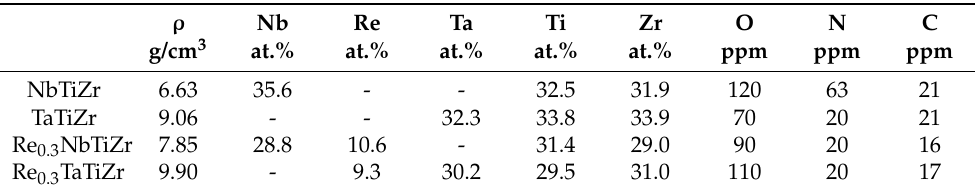
Table 1. Density ( ρ ) and composition of the produced alloys. The main elements are given in at.% and O, N, and C are given in weight parts per